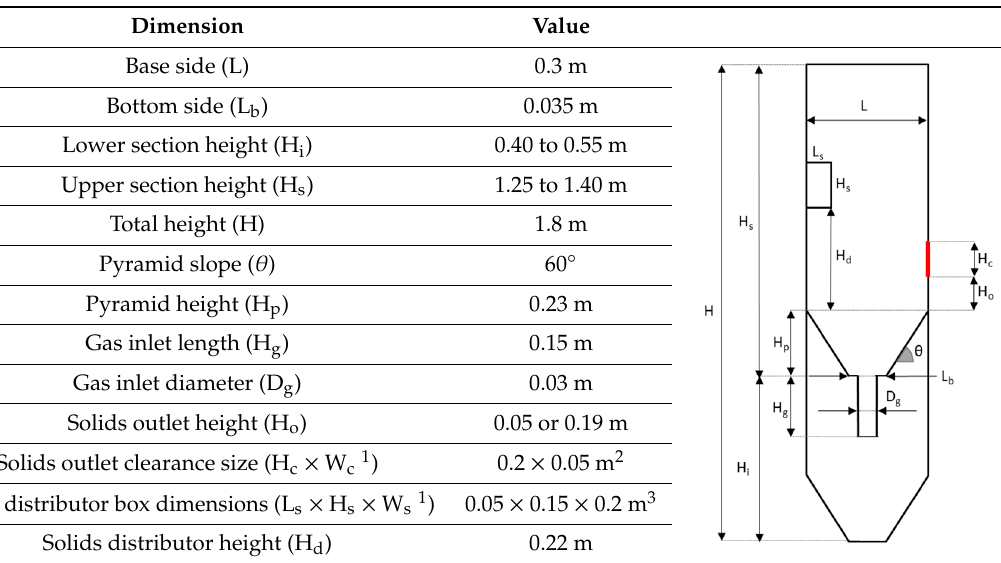
Figure 1. The two multi-spouted fluidization units. Table 1. Geometrical parameters of a single module.